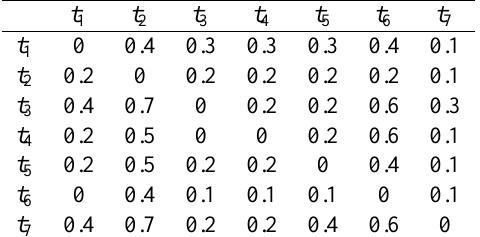
Table 6. Concordance degrees (Example 2b).